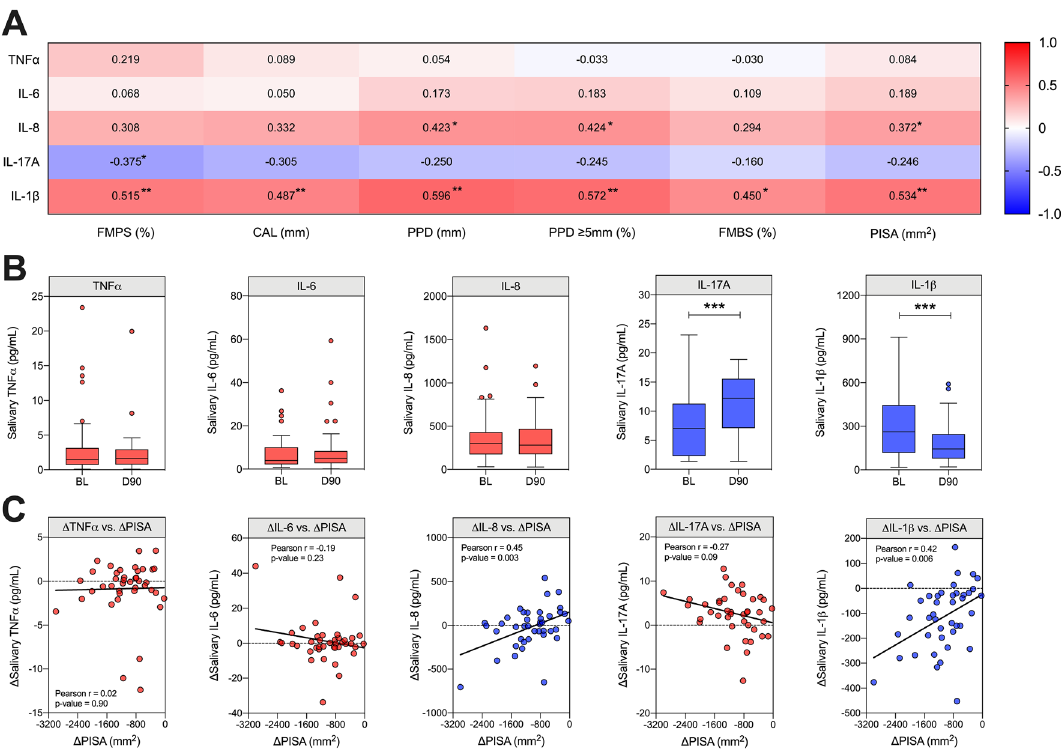
Figure 7. Levels of local inflammatory markers in saliva. ( A ) Correlating the levels of salivary inflammatory markers at baseline with clinical periodontal parameters, values represent Spearman-Rho correlation. P-values were corrected using FDR (5%) where * p (adjusted) < 0.05 and ** p (adjusted) < 0.01. Confidence intervals are supplied in supplementary dataset 1 ( B ) Comparing changes in the levels of TNFα, IL-6, IL-8, IL-17A and IL-1β at baseline (BL) and day-90 (D90). Graphs are Tukey boxplots where horizontal line indicates the median and individual points indicate potential outliers. Statistics are Wilcoxon signed rank test, where *** p < 0.001. n =